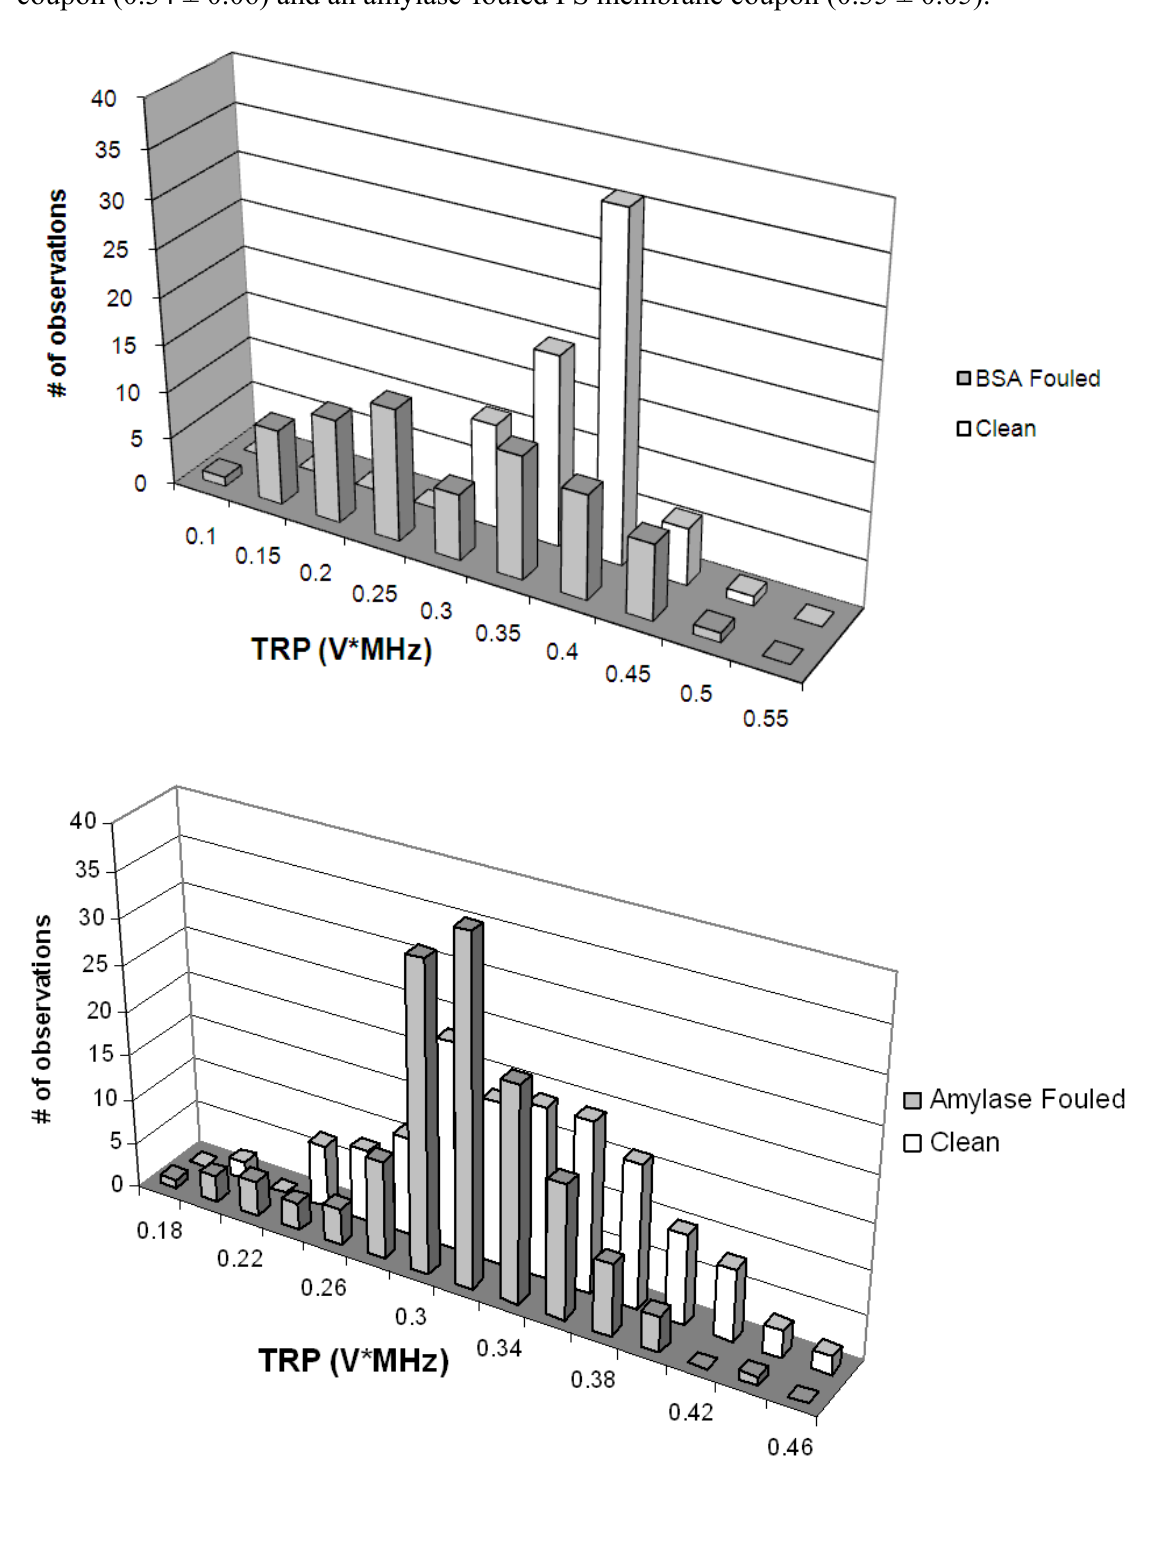
Figure 6. Total reflected power ( TRP) distributions obtained via scanning acoustic microscopy (SAM); mean and standard deviation of the distributions in units of VxMHz are presented in parentheses; TOP: a virgin PVDF membrane coupon (0.37 ± 0.06) and a BSA-fouled PVDF membrane coupon (0.32 ± 0.11); BOTTOM: a virgin PS membrane coupon (0.34 ± 0.06) and an amylase-fouled PS membrane coupon (0.35 ±